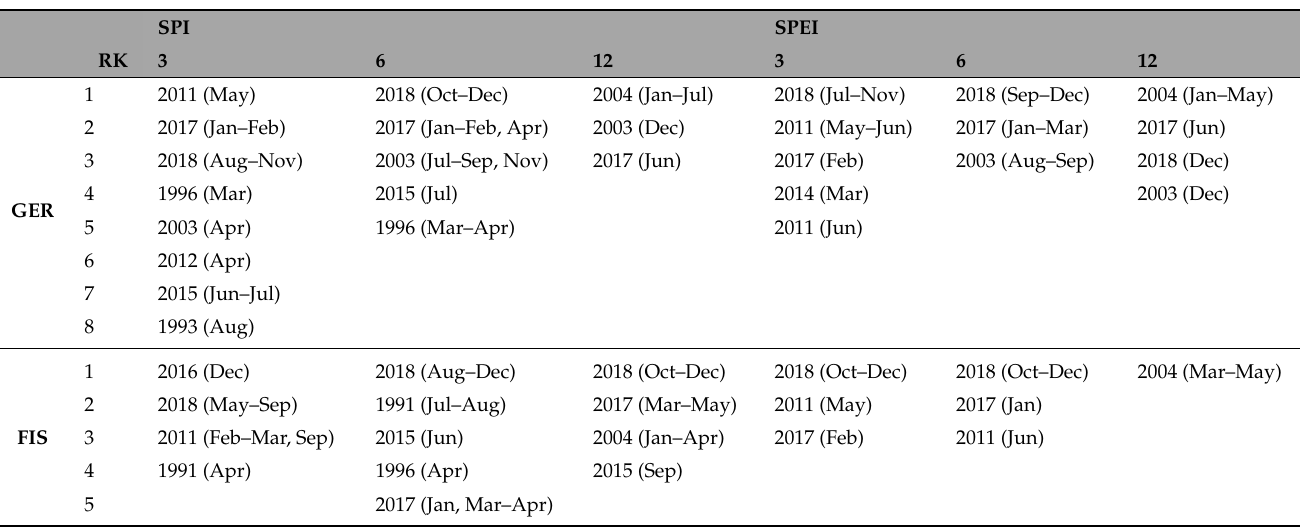
Table 4. Years with extreme drought events (SPI and SPEI ≤ − 2 and a probability of recurrence of 1 in 50 years) taking into consideration the 3-, 6-, and 12-month antecedent conditions in GER and